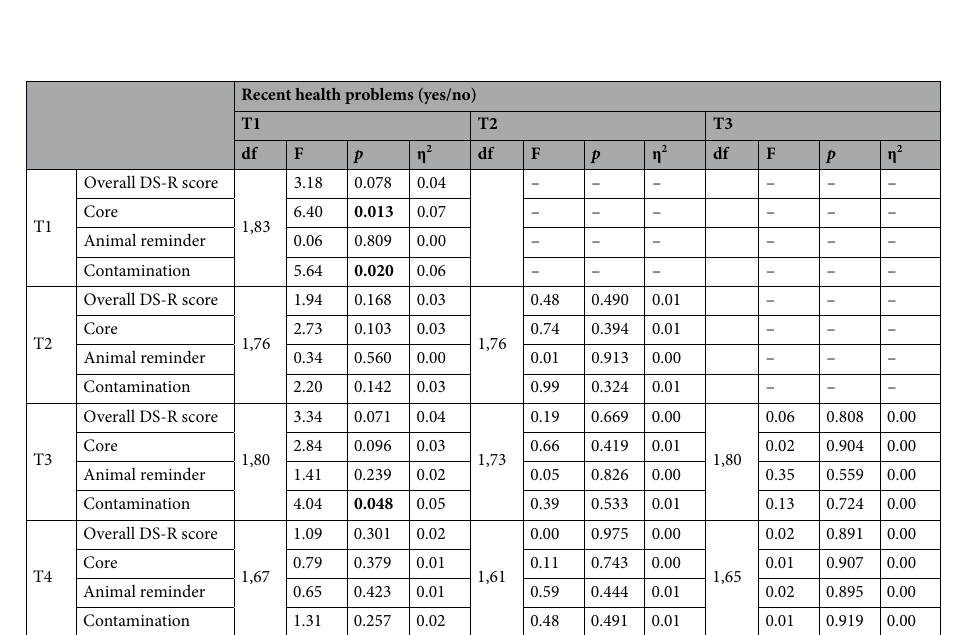
Table 2. ANCOVA tests showing the effect of recent health problems in each trimester on disgust sensitivity in different trimesters and after birth. Controlled for age and fetus sex. Significant values are in